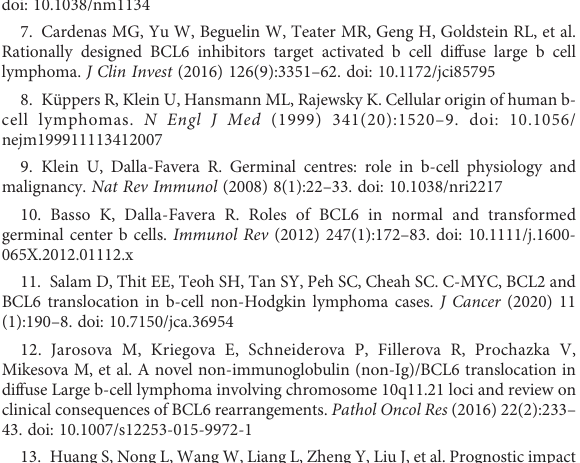
SUPPLEMENTARY FIGURE 3 NTA analysis for blank-Exo-siRNA and iRGD-Exo-siRNA. (A, B) The blank- Exo or iRGD-Exo were electroporated with BCL6 siRNA1. NTA analysis was used to assess the number and size of exosomes.